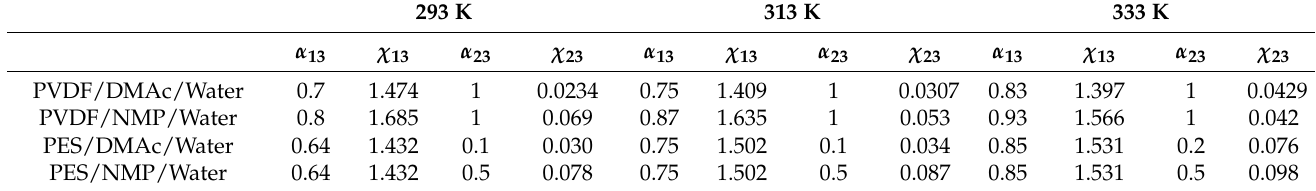
Table 6. Binary interaction parameters ( χ 13 and χ 23 ) at different temperatures from solubility pa- rameters with α 13 = α 13 = 1 and χ 123 = 0.